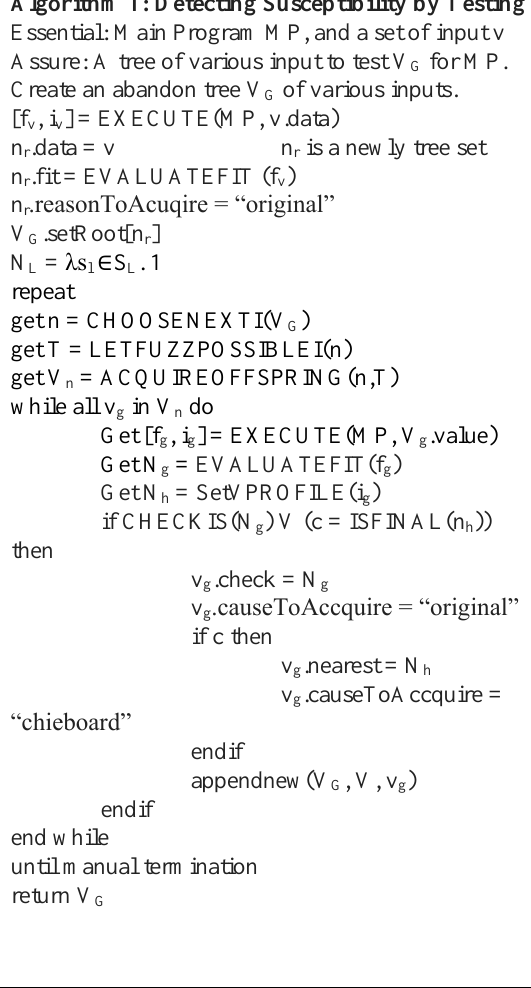
Algorithm 1: Detecting Susceptibility by